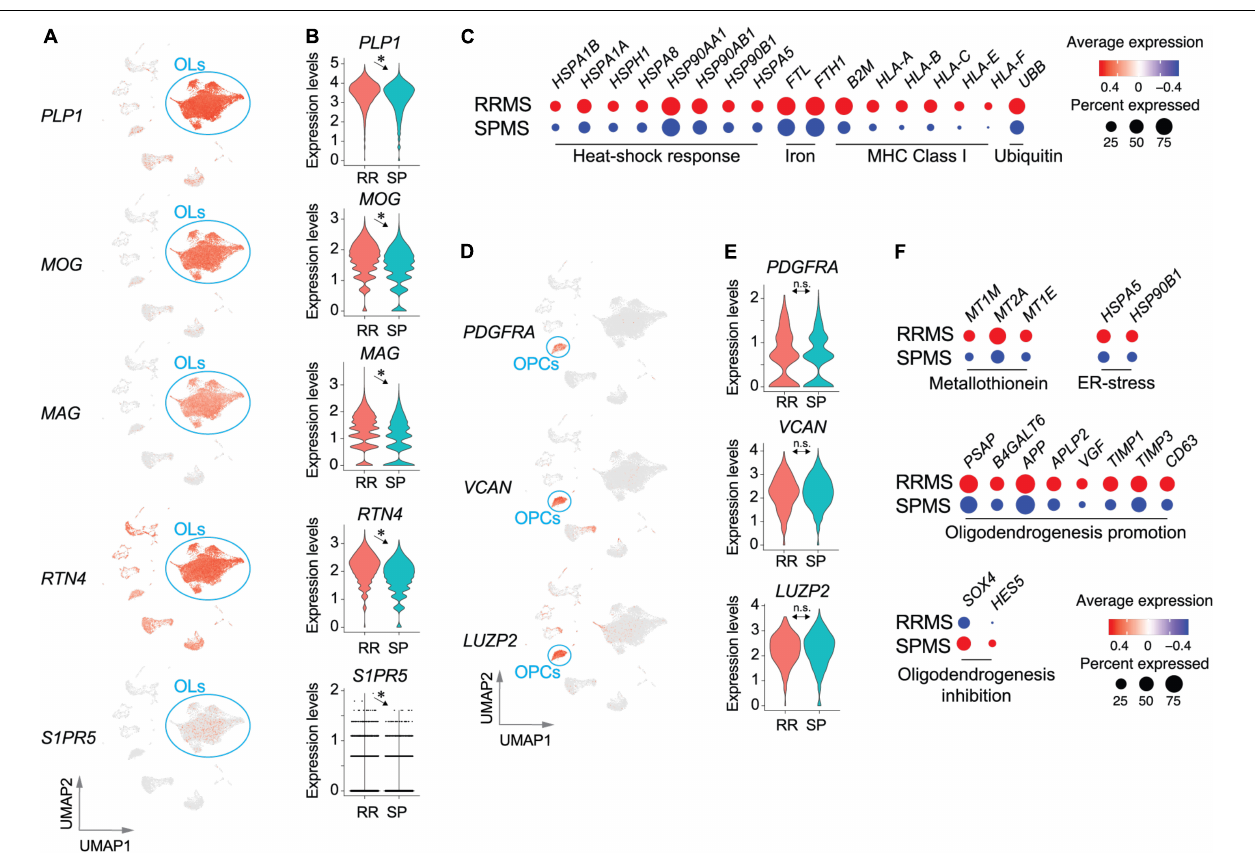
FIGURE 3 | Transcriptomic pathological signatures of MS oligodendrocytes (OLs) and oligodendrocyte progenitor cells (OPCs). UMAP (A) and violin plots (B) of OL marker genes. ∗ , adjusted p -value < 0.05. (C) Dot plots for genes associated with heat-shock response, iron accumulation, major histocompatibility complex class I, and ubiquitin-mediated protein degradation. Size and color indicate the CDRs and expression levels, respectively. UMAP (D) and violin plots (E) of OPC marker genes. n.s., non-significant. (F) Dot plots of genes associated with metallothionein pathway genes, ER-stress related genes, and oligodendrogenesis-promoting or inhibiting genes. Size and color indicate frequency and expression levels, respectively. Statistical results for DEGs, CDRs, and VAGs are provided in Supplementary Tables 4–6